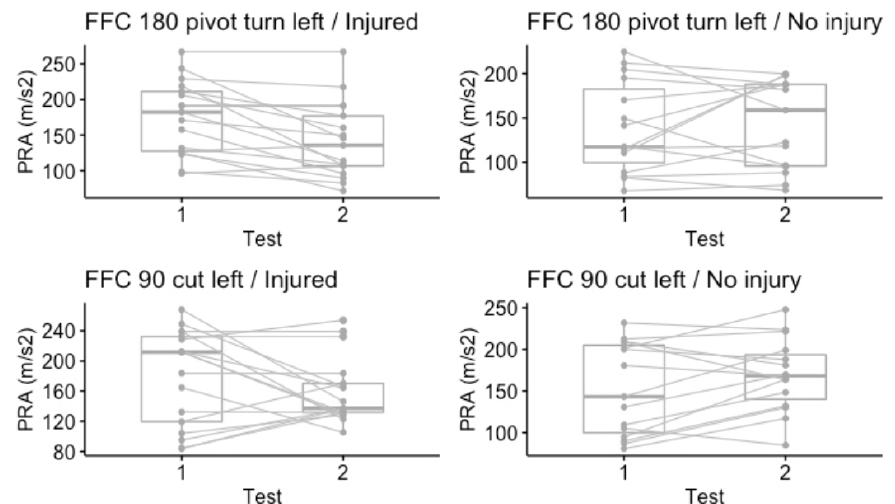
Figure 4. Boxplots showing the individual change of the peak resultant acceleration (PRA) (m/s 2 ) for